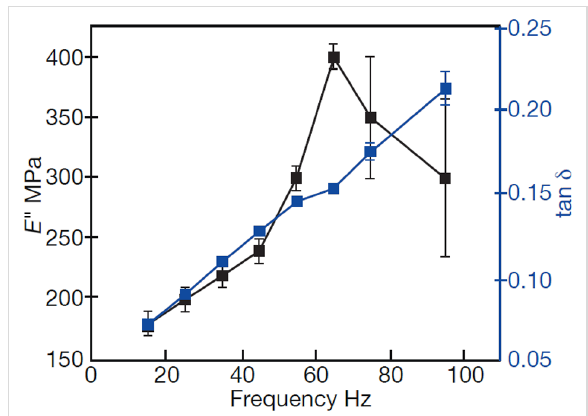
Figure 7: Dynamic INI of iPP as a function of the frequency. The error bars indicate the standard deviation calculated for at least five measurements in three different places.